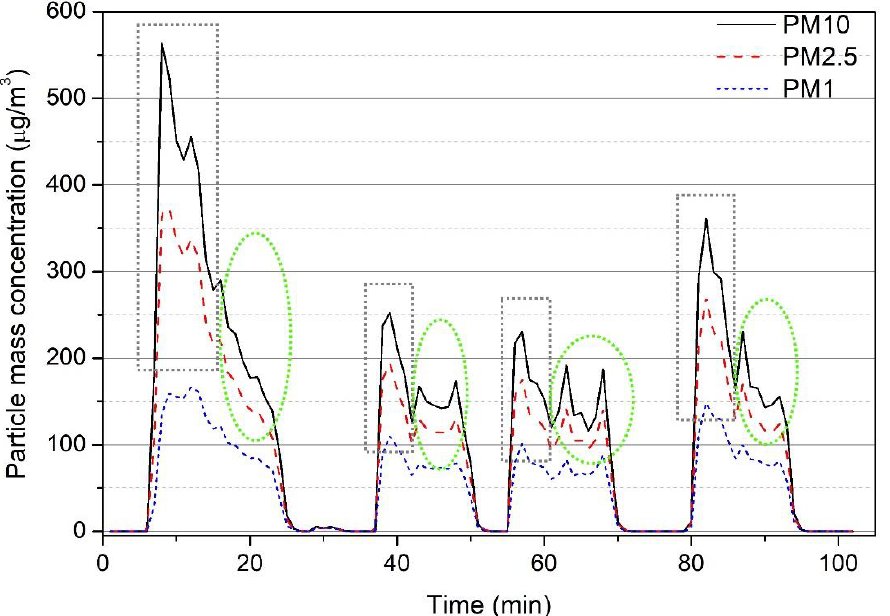
Figure 5. Particle mass concentrations in terms of PM10, PM2.5, and PM1 as measured by MiniWRAS for the four repetitions. Grey rectangles indicate running-in period and green ellipses indicate steady state.